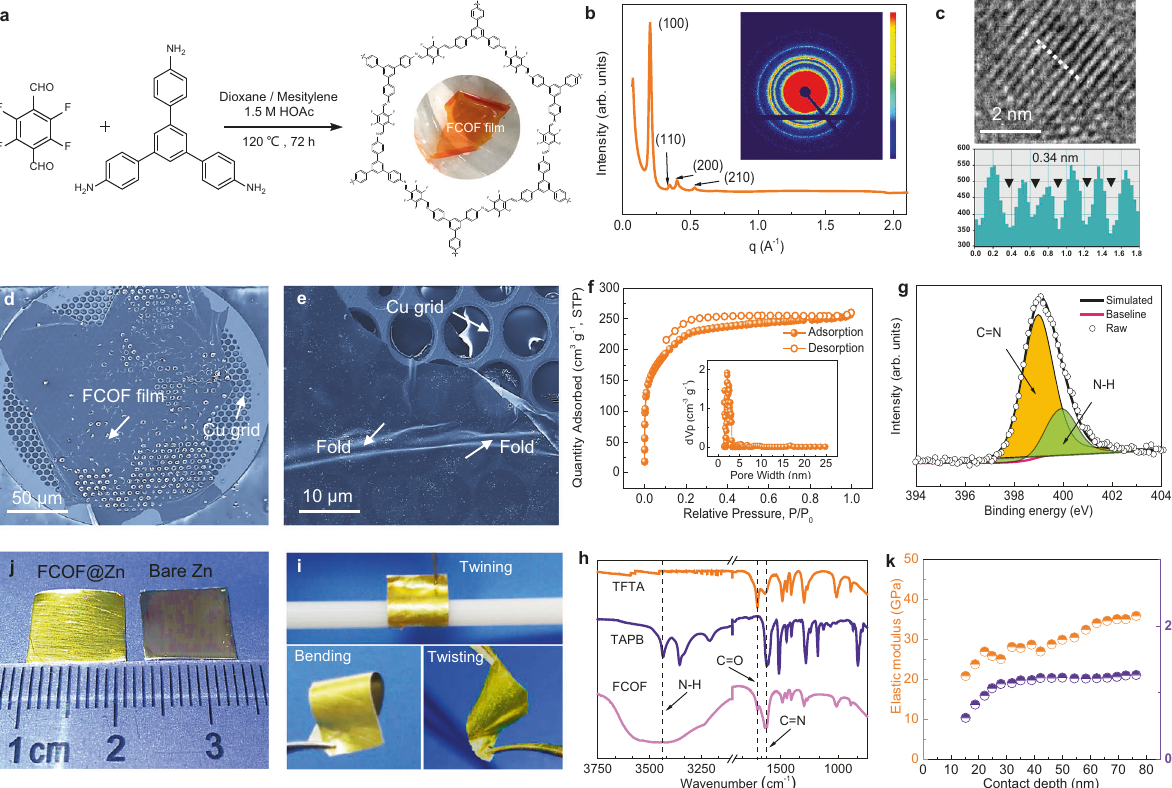
Fig. 2 The morphology and structure characterization of the FCOF fi lm. a Synthesis procedure of the FCOF fi lm. b WAXS result and its integrated curve. c HRTEM image and measurement of d- spacing. d , e FESEM images of the FCOF fi lm. f BET measurement and pore size distribution. g XPS result for N1 s in the FCOF fi lm. i , j Pictures of typical FCOF@Zn and typical bare Zn. h FTIR result for the monomers and the FCOF fi lm. k Nano-indentation measurement result for FCOF fi